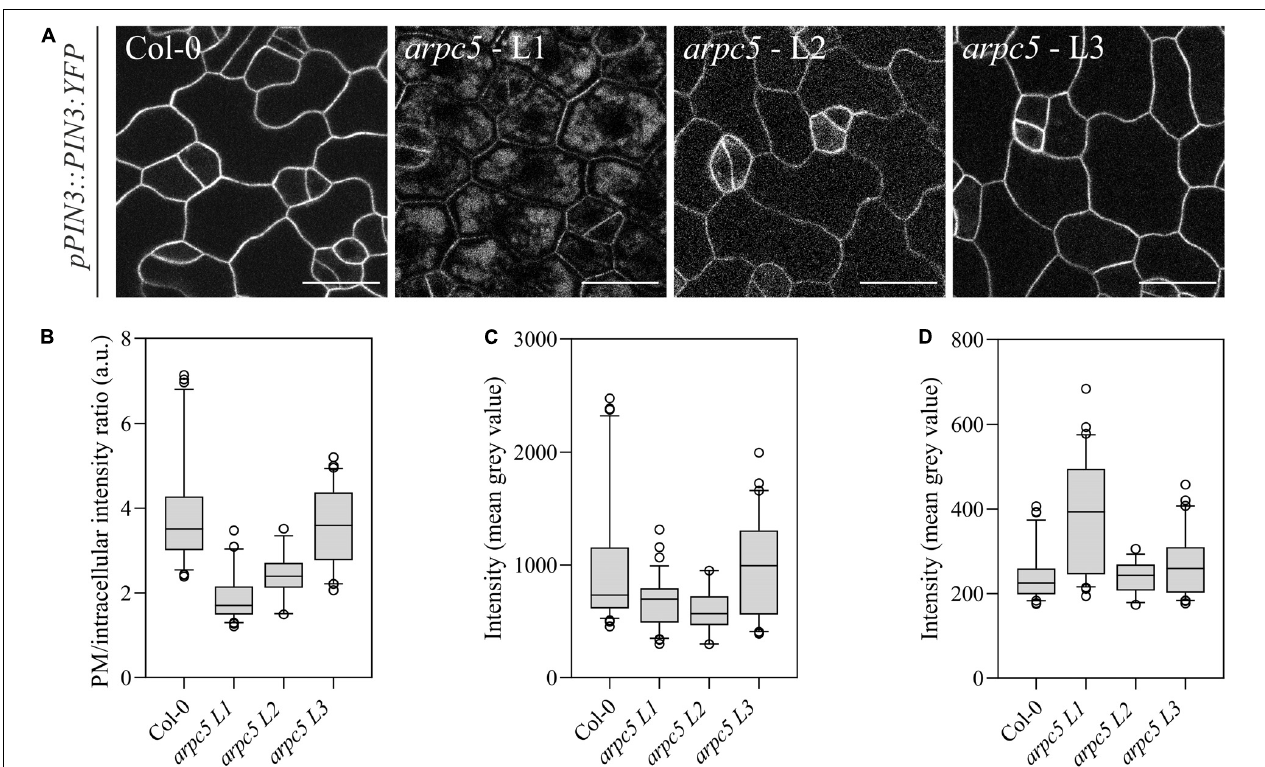
FIGURE 7 | Plants lacking functional ARP2/3 complex show altered PIN3 localization. (A) In vivo observation of pPIN3::PIN3:YFP in one-day-old plants was altered in three independent crosses between pPIN3::PIN3:YFP and arpc5 lines (L1-3); scale bar = 20 µ m. (B) The ratio between PM and intracellular PIN3-YFP intensity is reduced arpc5 mutants. (C,D) PIN3-YFP intensity was measured as the mean gray value for the areas representing the plasma membrane (C) and within the cell (D) . Results show that the differences in ratio are due to increased intracellular signal. n = 45–70 cells, three biological replicates (Tukey, HSD p <